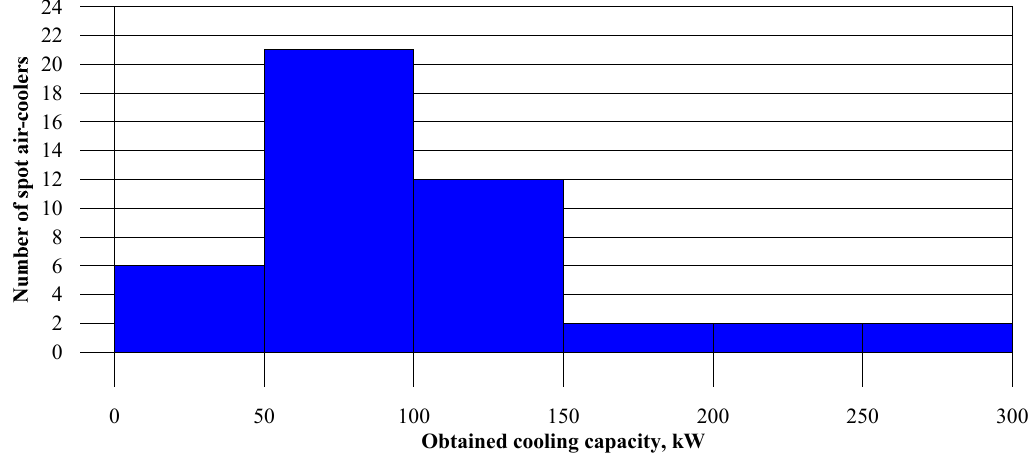
Figure 6. Bar chart of the cooling capacity of the investigated spot air-coolers of a rated cooling power, ranging 250–300 kW.